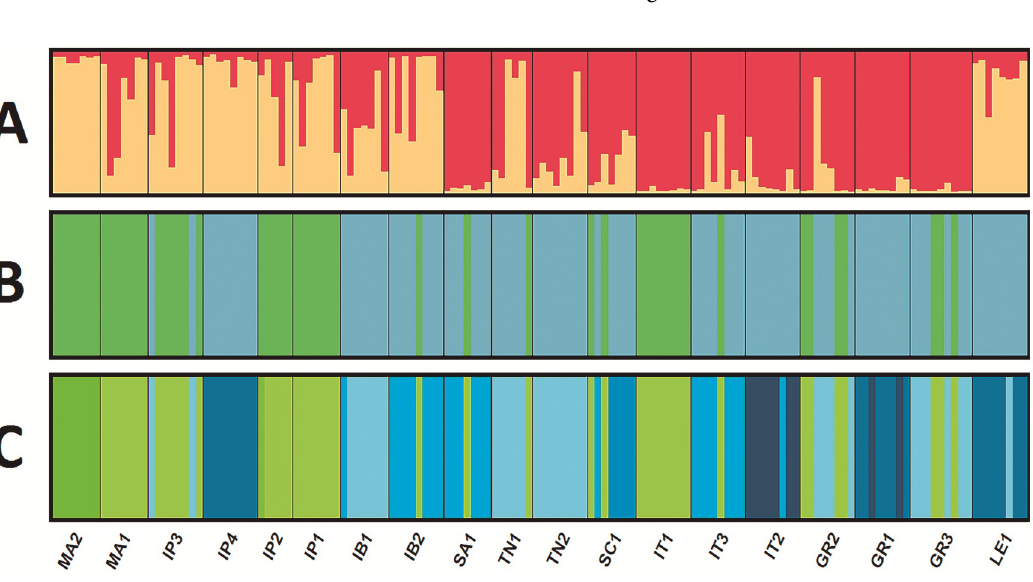
Fig 3. A: STRUCTURE results based on microsatellite loci for K = 2. Verticals lines represent proportional assignation to each genetic cluster. Black lines delimit the different localities; yellow—cluster 1, red—cluster 2. B: Representation of the phylogenetic clades based on the cox1 sequences to which each individual belongs; green—clade A, blue—clade B. C: Representation of the lineages to which each individual belongs; Same colors for the lineages as colored bars in Fig 2. Abbreviations: GR (Greece), IB (Balearic Islands), IP (Iberian Peninsula), IT (Italy), LE (Israel), MA (Morocco), SA (Sardinia), SC (Sicily), TN (Tunisia).